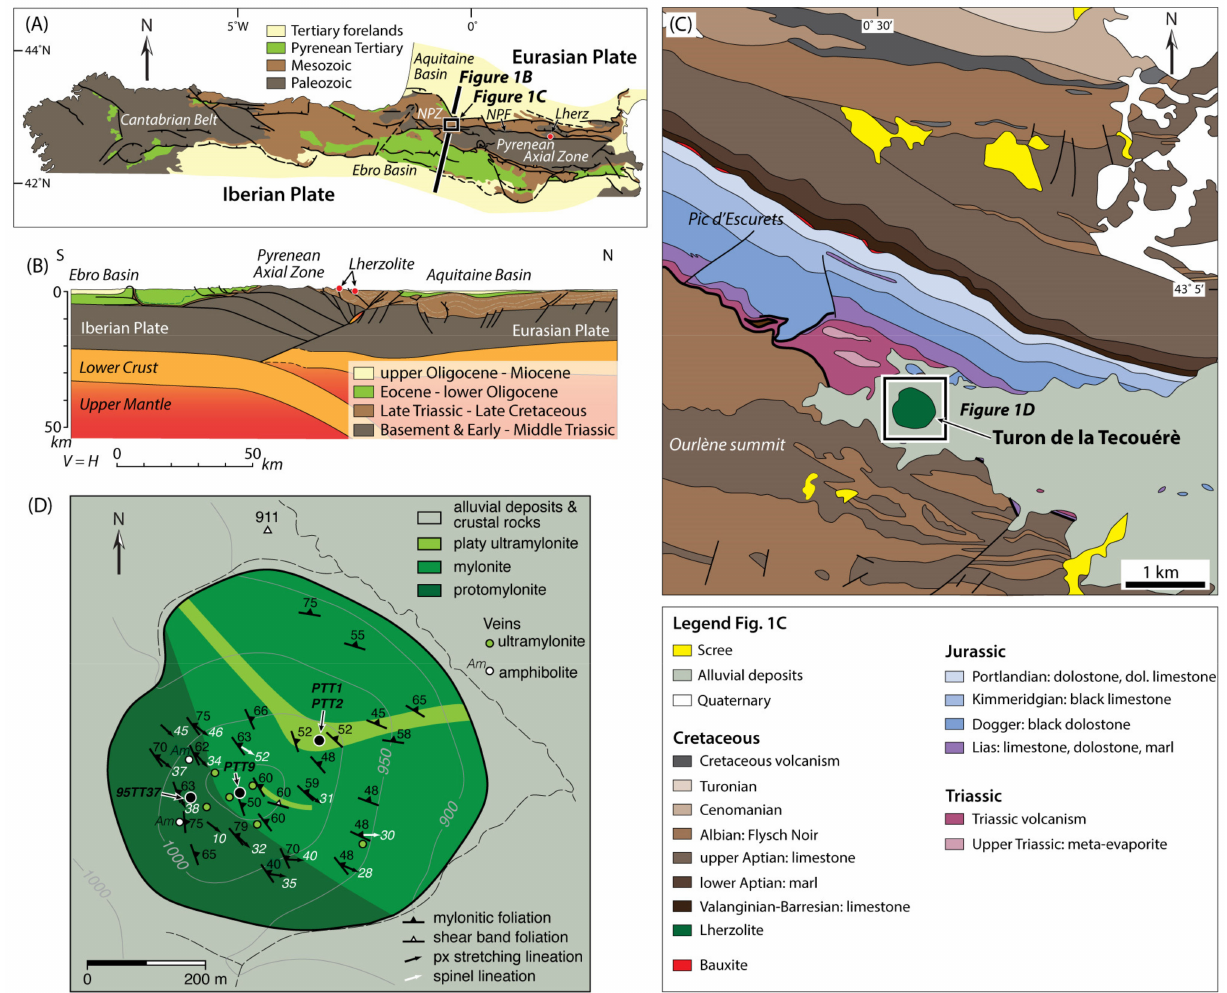
Figure 1. ( A ) Tectonic map of the Pyrenean-Cantabrian orogenic belt indicating the location of Chaînons B é arnais-Jaca section line. The black box shows the location of the Turon de T é cou è re massif and the red circle the location of the Lherz massif. NPZ = North Pyrenean Zone; NPF = North Pyrenean Fault ( B ) The lithospheric-scale Chaînons B é arnais- Jaca geological section modified from [34]. The location of the exhumed peridotite bodies is shown on the cross section. ( C ) Geological map of the Chaînons B é arnais [44] and location of the Turon de T é cou è re peridotite massif. ( D ) Structural map of Turon de T é cou è re showing distribution of main mylonitic domains, modified after [12]. The locations of the studied samples are plotted on the